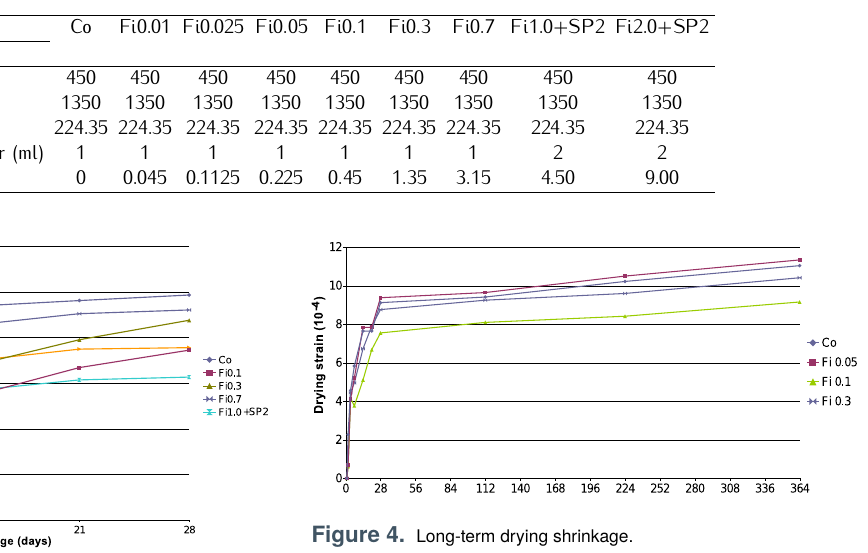
Table 2. Mix proportions of mortar specimens.